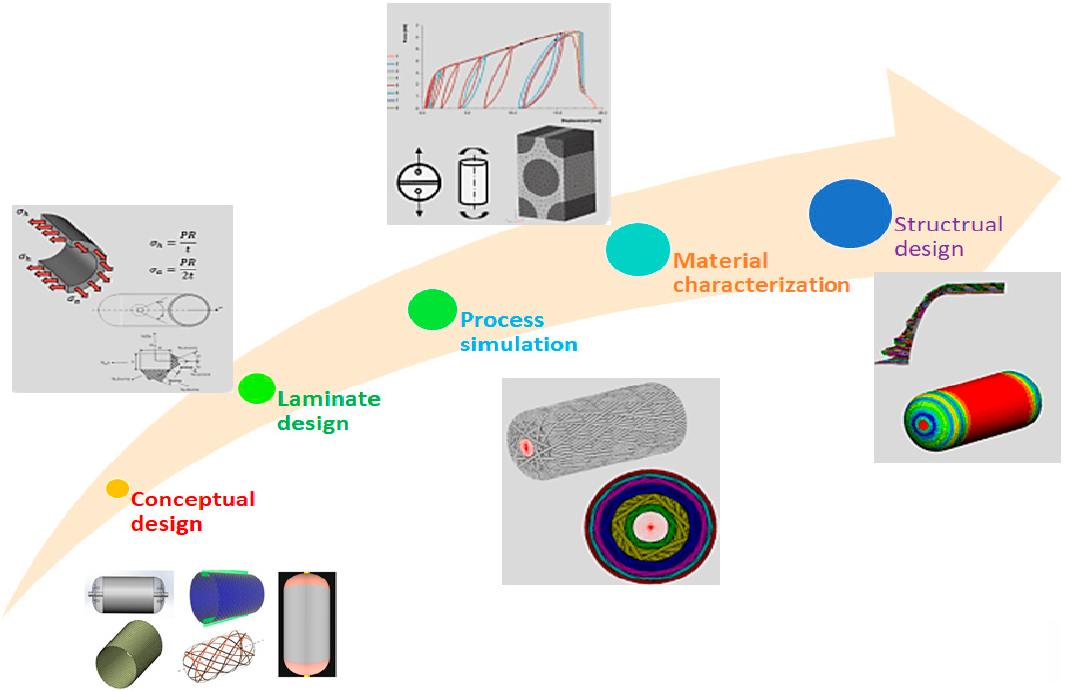
Figure 8. Design methodology of hydrogen storage vessels.